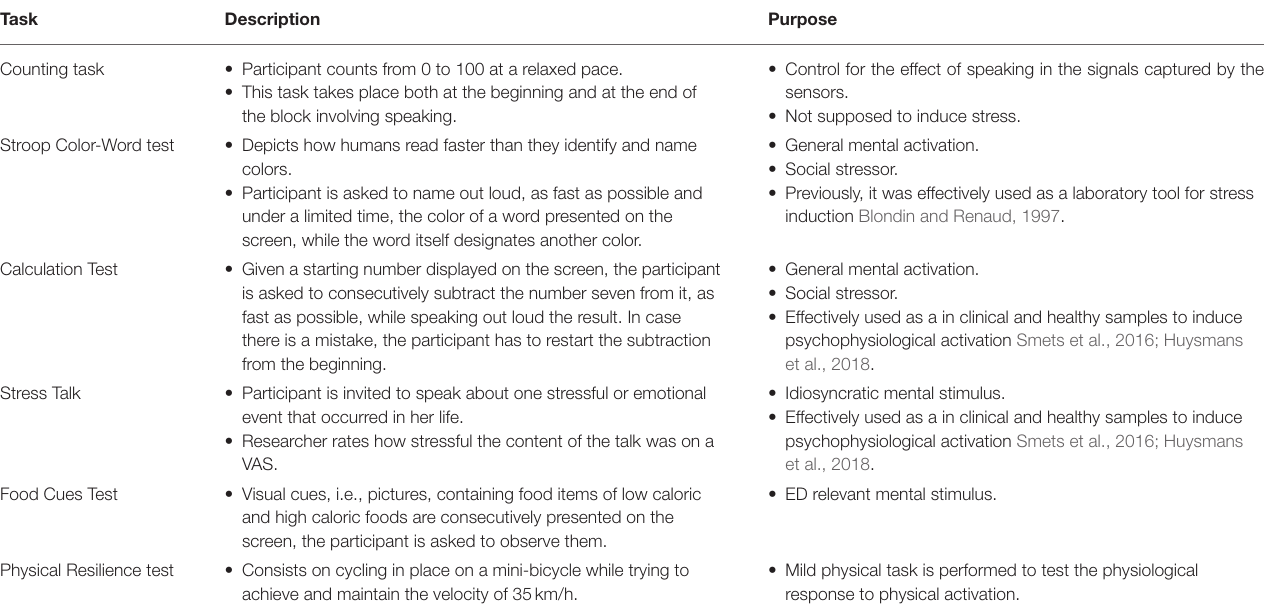
TABLE 4 | Detailed description of the stress task modules and their purpose in our